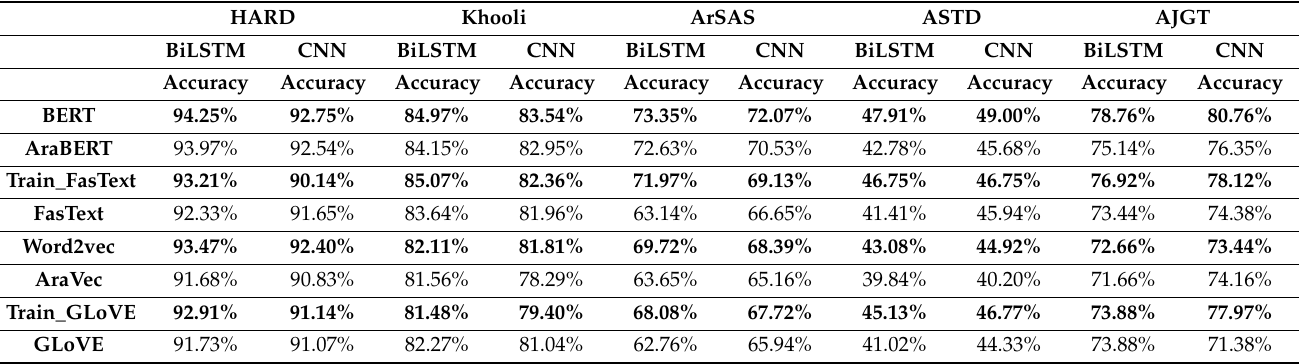
Table 7. Pretrained embeddings F1-measures.